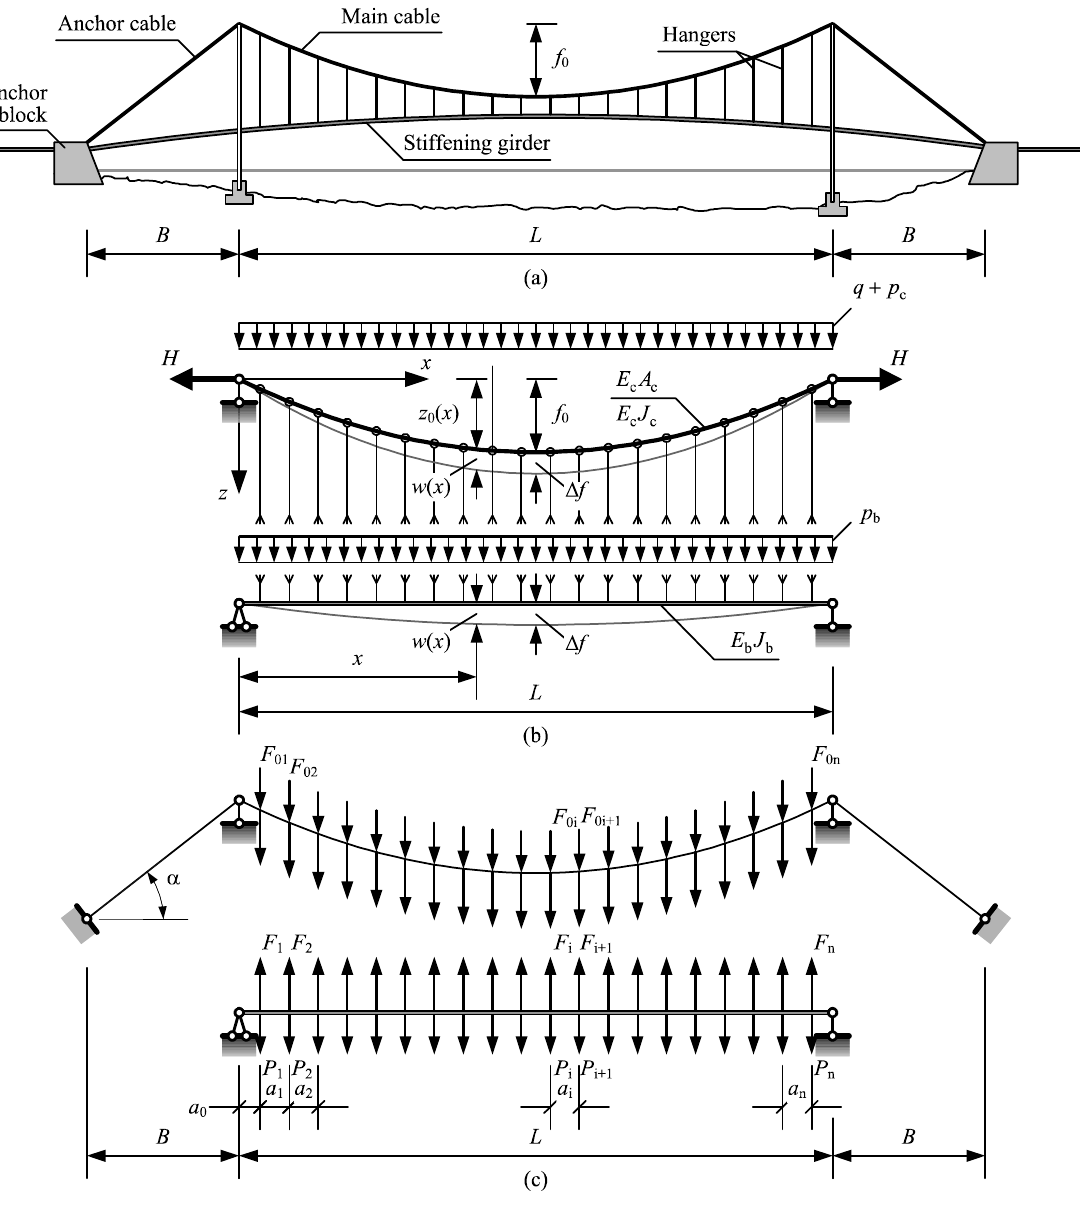
Fig. Calculation model for a suspension